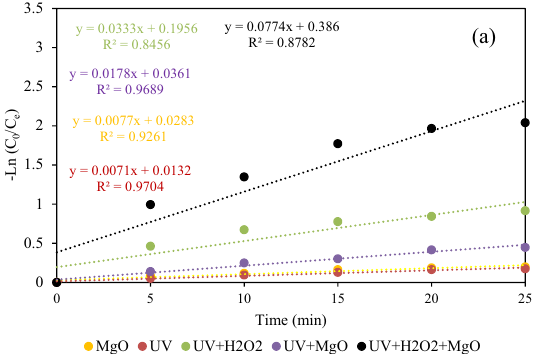
Figure 12. The degradation of DEX under MgO, UV, UV/H 2 O 2 , UV/MgO, and UV/H 2 O 2 /MgO processes based on a pseudo-first-order model.